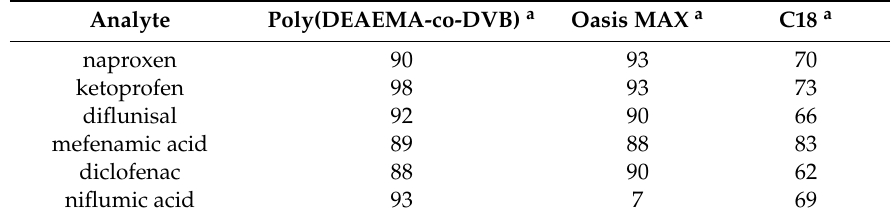
Table 5. Comparison of recovery performance between poly(DEAEMA-co-DVB) with commercial SPE columns.